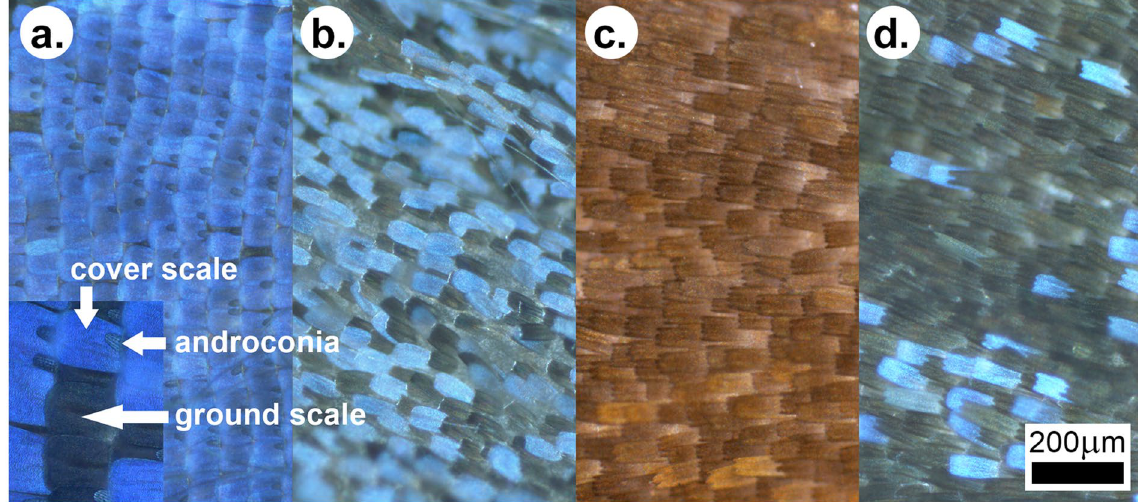
Figure 5. Optical microscopy of the wings. ( a ) Wild male, ( b ) male from a pupa cooled for 22 days, ( c ) wild female, ( d ) female from a pupa cooled for 20 days. The inset in the lower left corner shows magnified examples of the cover scales, ground scales and the androconia of the